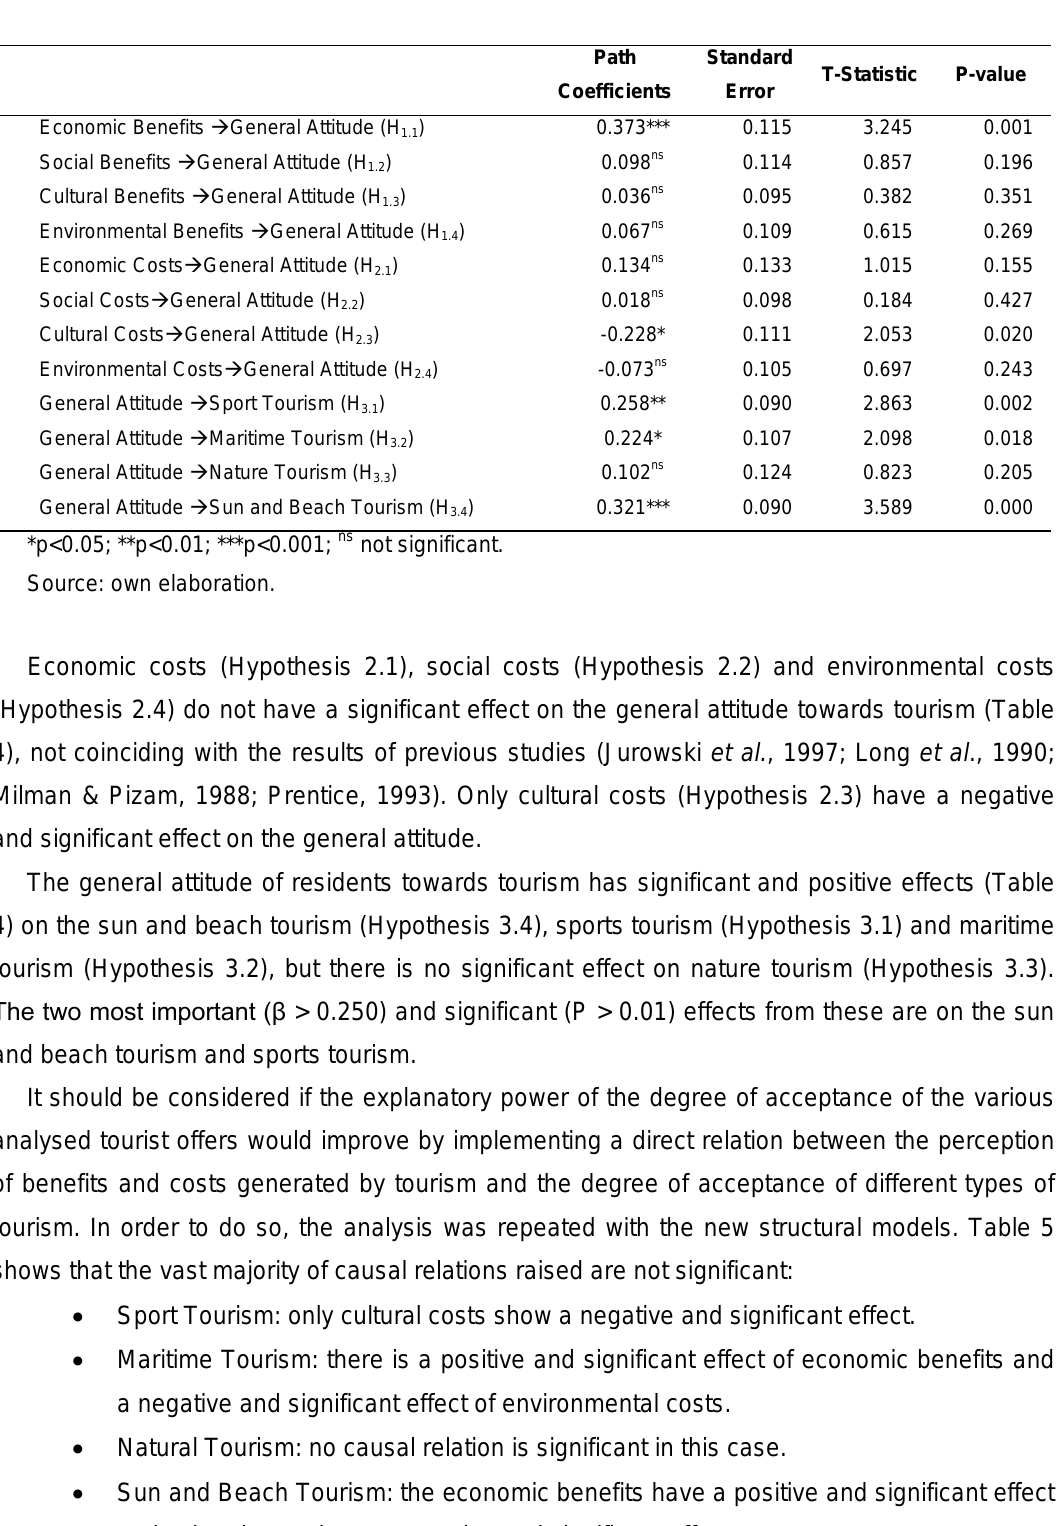
Table 5. Alternative